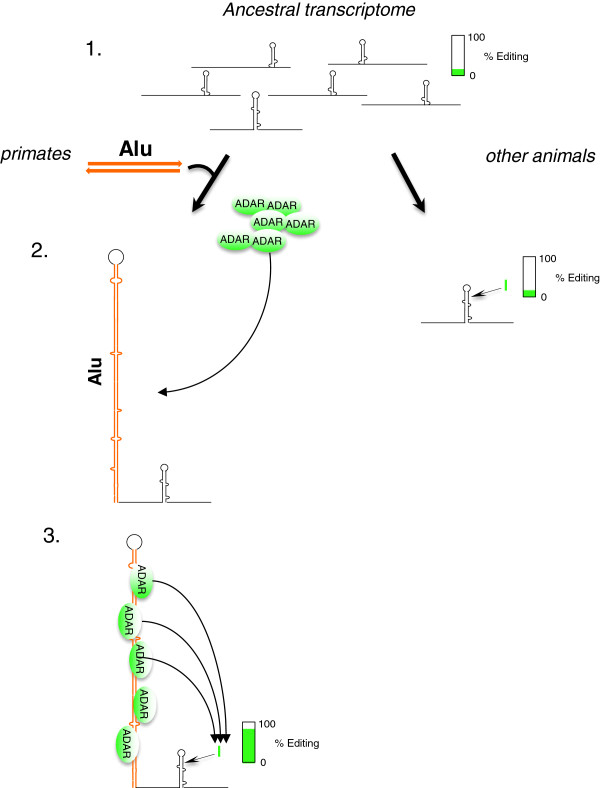
A model for human- or primate-specific adenosine to inosine editing induced by Alu inverted repeats. (1) All metazoans have a basic low level of RNA editing in their transcriptome of 1% to 2%. (2) Alu elements have been integrated into the primate genome. Pairs of adjacent Alus with inverted orientation, form long and stable duplexes in transcripts, which act as recruitment elements for the ADAR enzymes. (3) A high ADAR concentration at the inverted Alus gives high editing efficiency at single sites in nearby short hairpins.